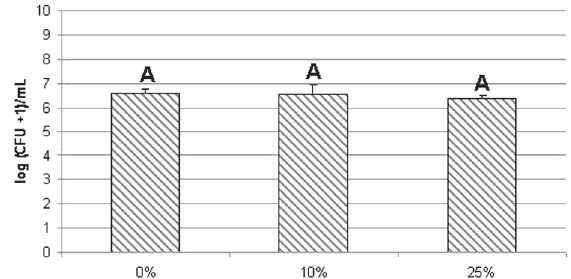
Figure 3 - Effect of different percentages of poly(2-tert- butylaminoethyl) methacrylate (PTBAEMA) incorporated into acrylic resin specimens on the viability of Candida albicans biofilm cells. Error bars represent standard deviations ( α =0.05). Identical capital letters denote no significant differences among groups (Kruskal–Wallis test, p